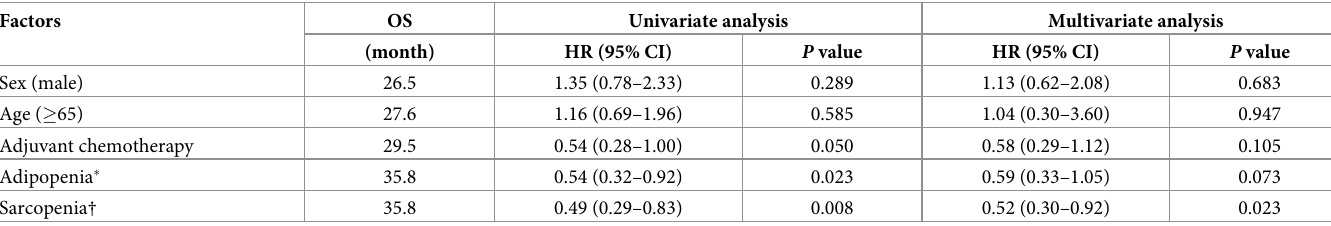
Table 3. Prognostic factors for overall survival in the univariate and multivariate analyses at 6 months after resection of pancreatic cancer. Factors OS Univariate